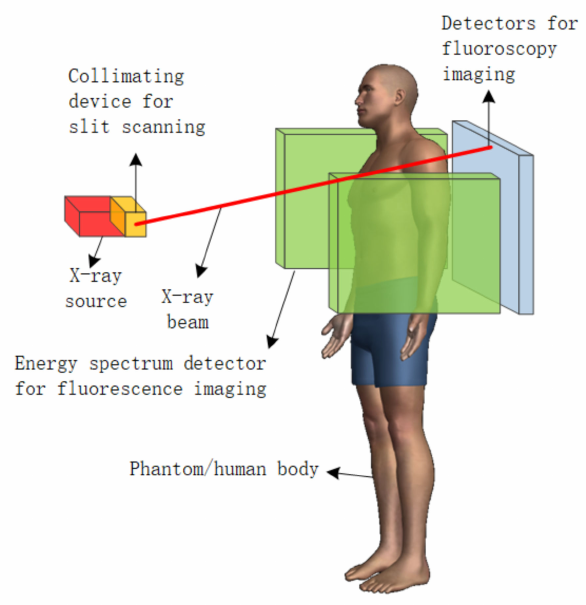
Figure 1. Schematic diagram of the device for pencil beam spot scanning